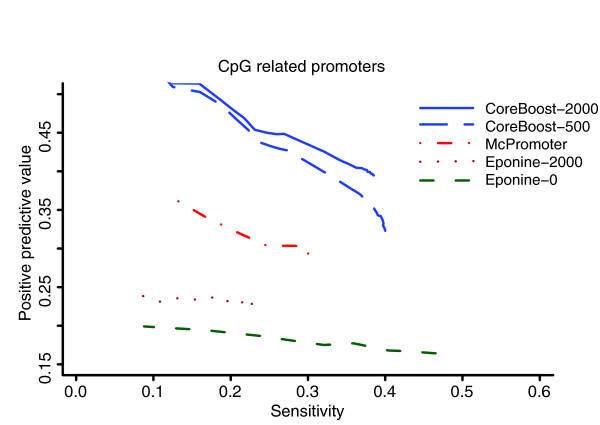
Positive predictive value versus sensitivity for CpG-related promoters. The solid and the long dashed curves are for CoreBoost, with the solid one for the cases clustering predictions within 2,000 bp and the long-dashed one within 500 bp. The dot-dashed curve is for McPromoter which clusters predictions within 2,000 bp as default. The dot and the short-dashed curves are for Eponine, with the dot one for the cases clustering predictions within 2,000 bp and the short-dashed one from the default output of Eponine. bp, base pairs.